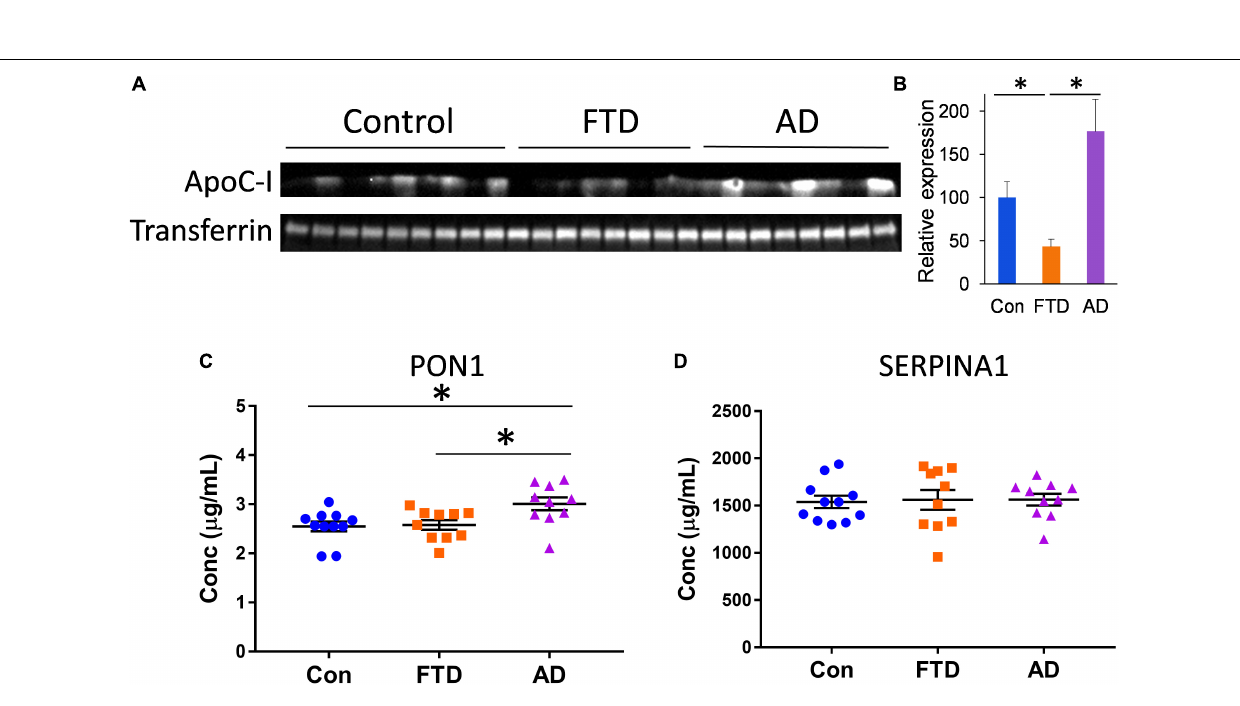
FIGURE 6 | ApoC-I, PON1, and SERPINA1 levels in whole plasma in bvFTD, AD, and controls. (A) Western blotting of plasma apoC-I; transferrin was used as a loading control. (B) Relative optical density of protein bands; data represent mean and SE as error bars, ∗ p < 0.05. (C) PON1 levels were significantly increased in AD compared to both bvFTD and controls as measured by ELISA; bars represent mean and SE, ∗ p < 0.05. (D) SERPINA1 levels were unaltered in both bvFTD and AD compared to controls as measured by